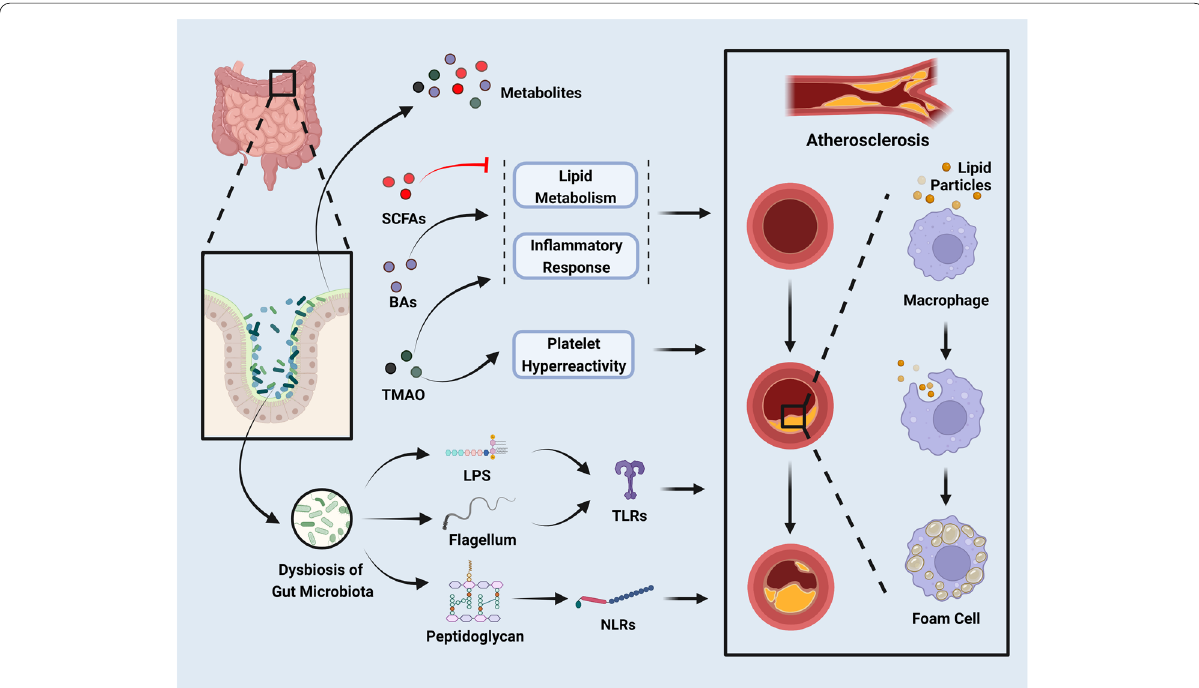
Fig. 5 The relationship between gut microbiota and atherosclerosis (created with BioRender.com). Due to the accumulation of cholesterol in the vascular wall, macrophages engulf lipid particles and convert them into foam cells, further aggravating atherosclerosis. The dysbiosis and metabolites of gut microbiota can influence the course of atherosclerosis. In general, SCFAs are beneficial for improving atherosclerosis, while BAs and TMAO may aggravate the progression of atherosclerosis. Abbreviations: SCFAs: short-chain fatty acids; TMAO: trimethylamine N-oxide; BAs: bile acids; LPS: lipopolysaccharide; TLRs: Toll-like receptors; NLRs: Nod-like